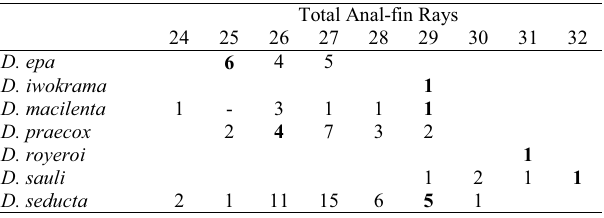
Table 18. Number of specimens of the species of Denticetopsis with cited number of total anal-fin rays. Bold indicates value for holotype when examined.